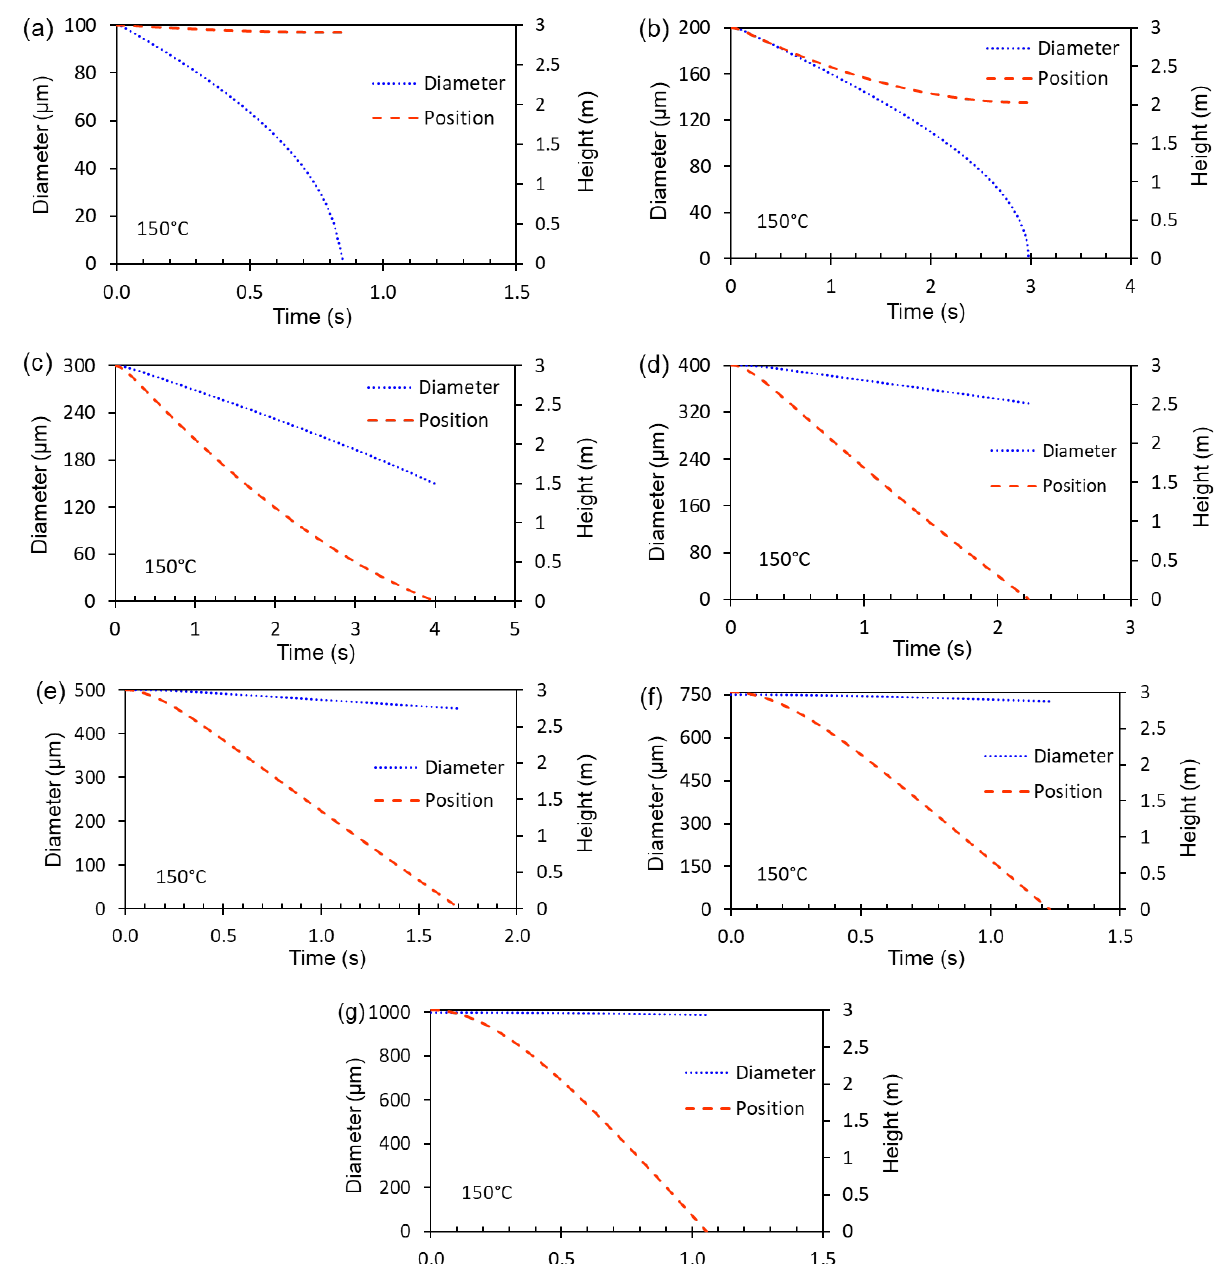
Figure 5. Diameter and position history of droplets with different initial diameters at condition 2 (150 °C); ( a ) 100 µm; ( b ) 200 µm; ( c ) 300 µm; ( d ) 400 µm; ( e ) 500 µm; ( f ) 750 µm; and ( g ) 1000 µm. (150 ◦ C); ( a ) 100 µ m; ( b ) 200 µ m; ( c ) 300 µ m; ( d ) 400 µ m; ( e ) 500 µ m; ( f ) 750 µ m; and ( g ) 1000 µ